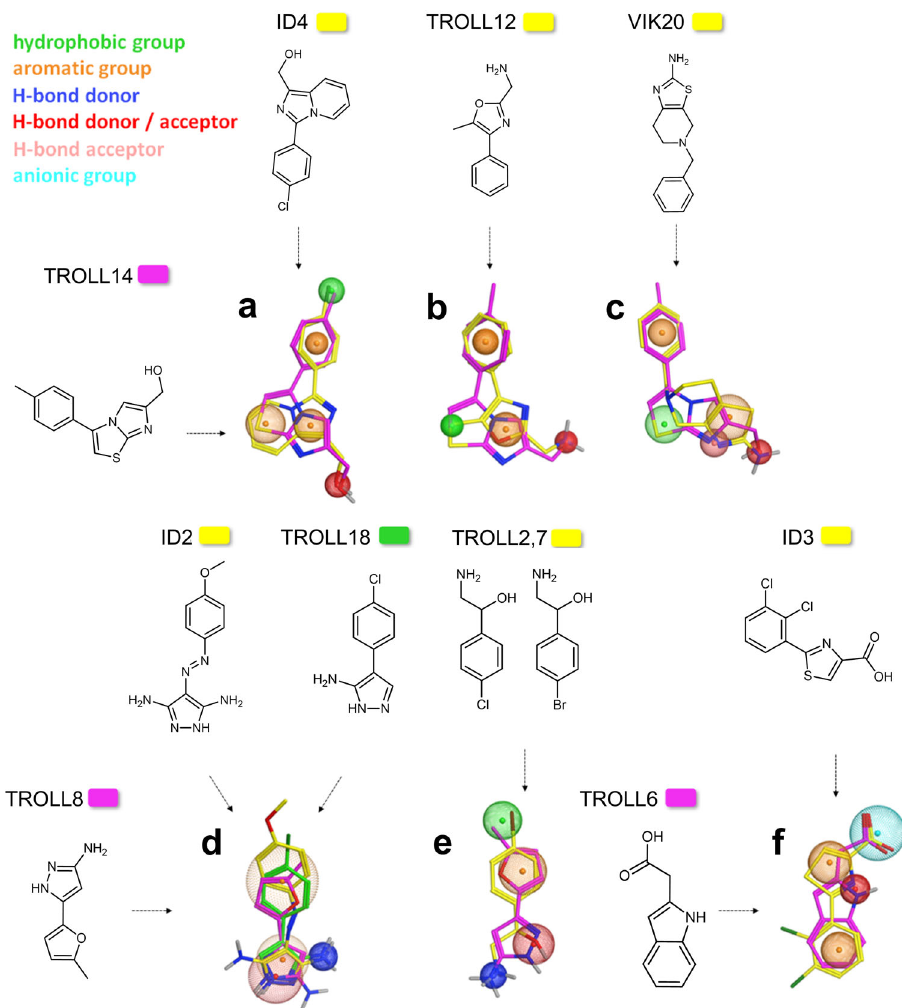
Fig. 4 Pharmacophore models derived from selected fragments binding to p97-N. Fragments of this study and from Chimenti et al. 26 were superimposed with respect to similar chemical properties or recognition elements. Spheres represent similar functional groups present in both fragments. The chemical properties of the spheres are explained in the colour code (top left). The resulting pharmacophore models a – f are described in the main text.